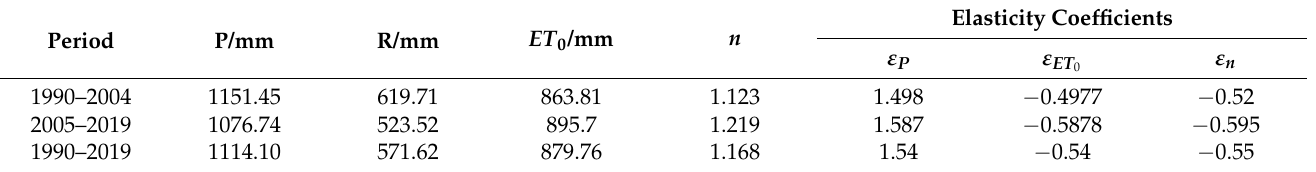
Table 5. Statistics of hydrological and climatic factors in the Wujiang River Basin during the study